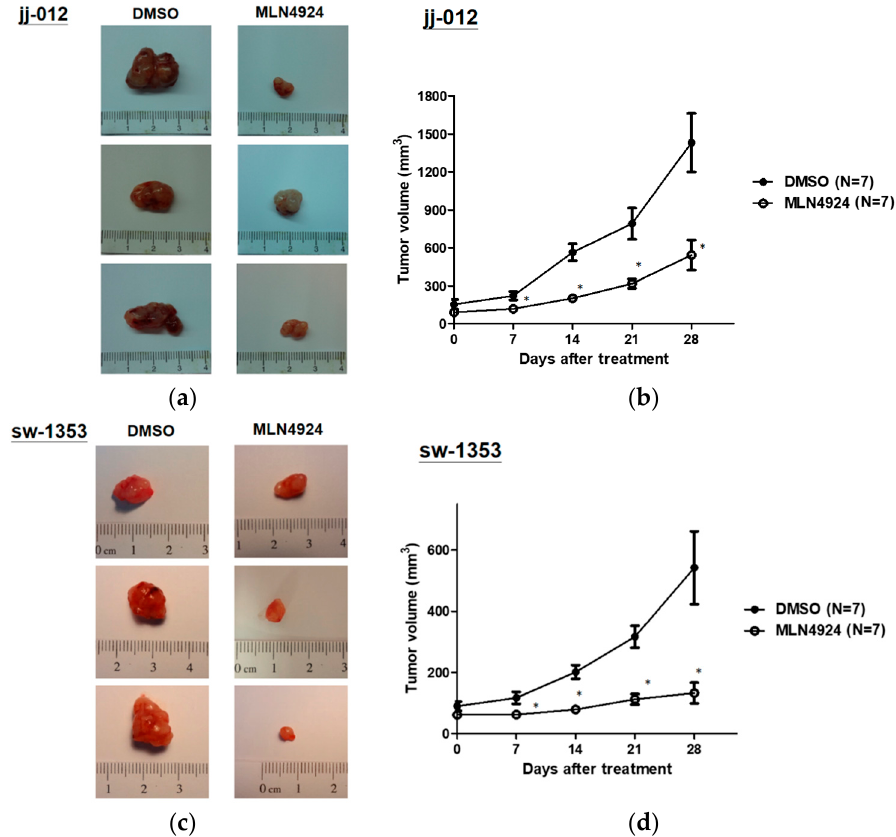
Figure 5. MLN4924 significantly inhibited the growth of the chondrosarcoma xenograft in vivo. Mice with jj012 or sw-1353 cells were grouped for treatment with DMSO or MLN4924 (10 mg/kg/day) through intraperitoneal injection for 5 weeks. ( a , c ) Representative images of excised chondrosarcoma tumors from each group of cells. ( b , d ) Tumor volumes were recorded to assess tumor growth. On the last day of treatment, tumors from MLN4924-treated and DMSO control mice were compared. * p < 0.05 versus DMSO control mice. The weights and volumes of tumors are represented herein as mean ± standard error of the mean; * p < 0.05.